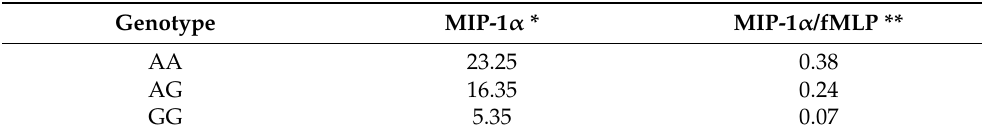
Table 3. [Ca 2+ ] i measurements calculated upon stimulation with MIP-1 α in patients with Löfgren’s syndrome according to rs1799987